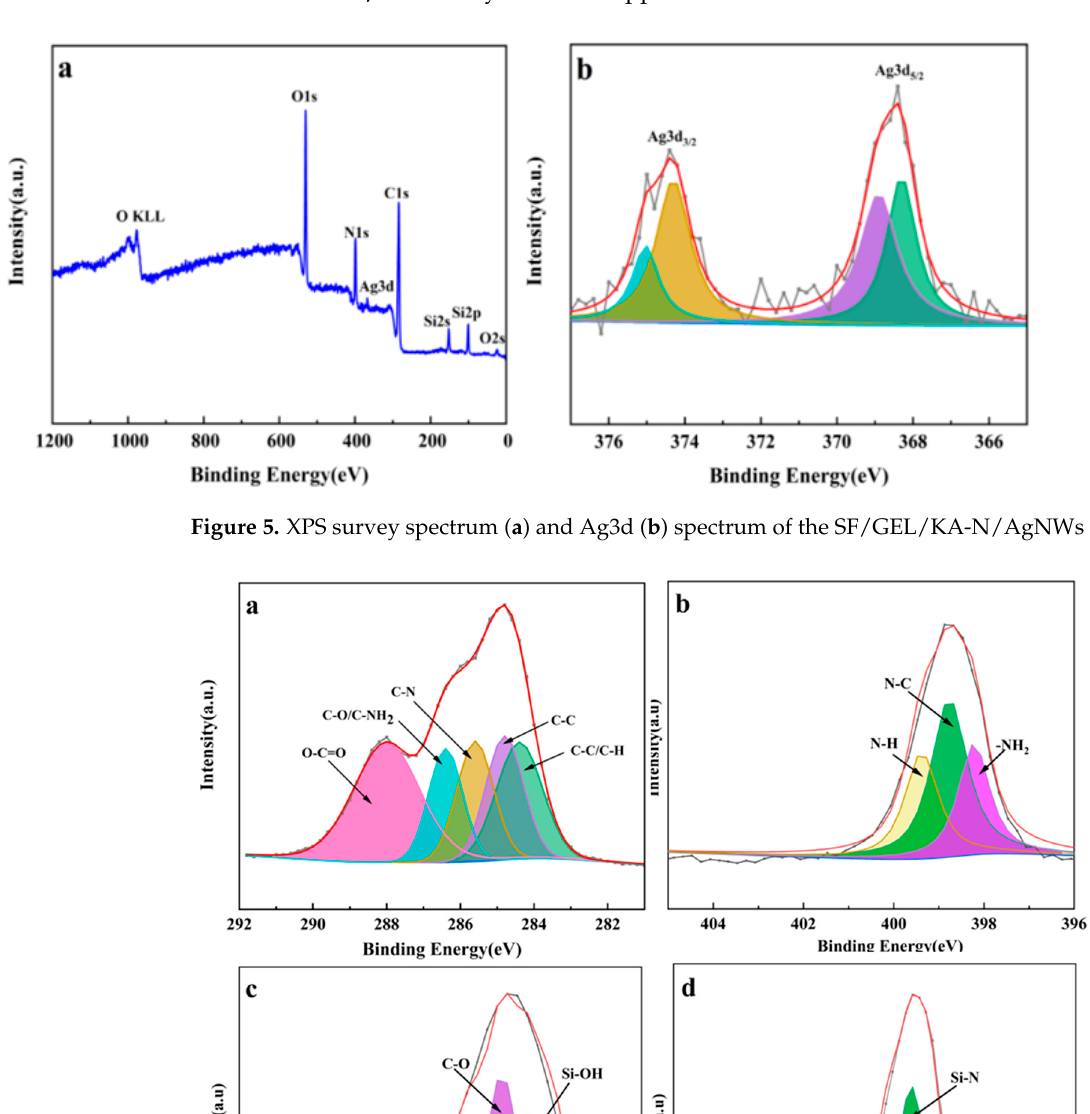
Figure 7. Schematic diagram of the proposed interactions between SF, Gel, KA-N, and AgNWS. 3.4. Properties of Antibacterial Activity Figure 8 shows the antibacterial results of the prepared samples against E. coli and S. aureus . Samples SF/GEL and SF/GEL/KA-N do not show antibacterial activity. Previous studies have shown that AgNWs have excellent antibacterial activity against E. coli and S.